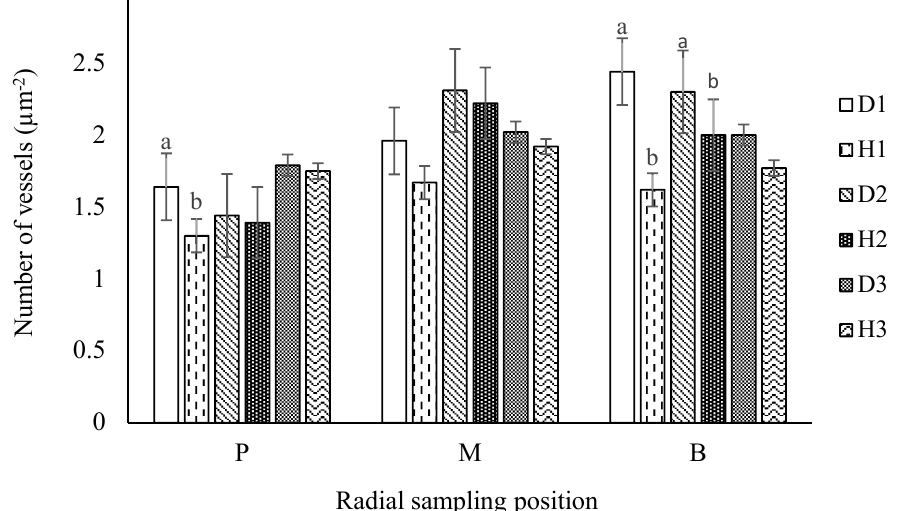
Figure 6. Mean number of vessels in declined and healthy trees of Quercus brantii . H: Healthy trees; D: Declined trees; 1: Area A; 2: Area B; 3: Area C; P: Near-pith; M: Middle; B: Near-bark. The bar on each column represents the SE (standard error). Columns with no letters on them indicate insignificance.